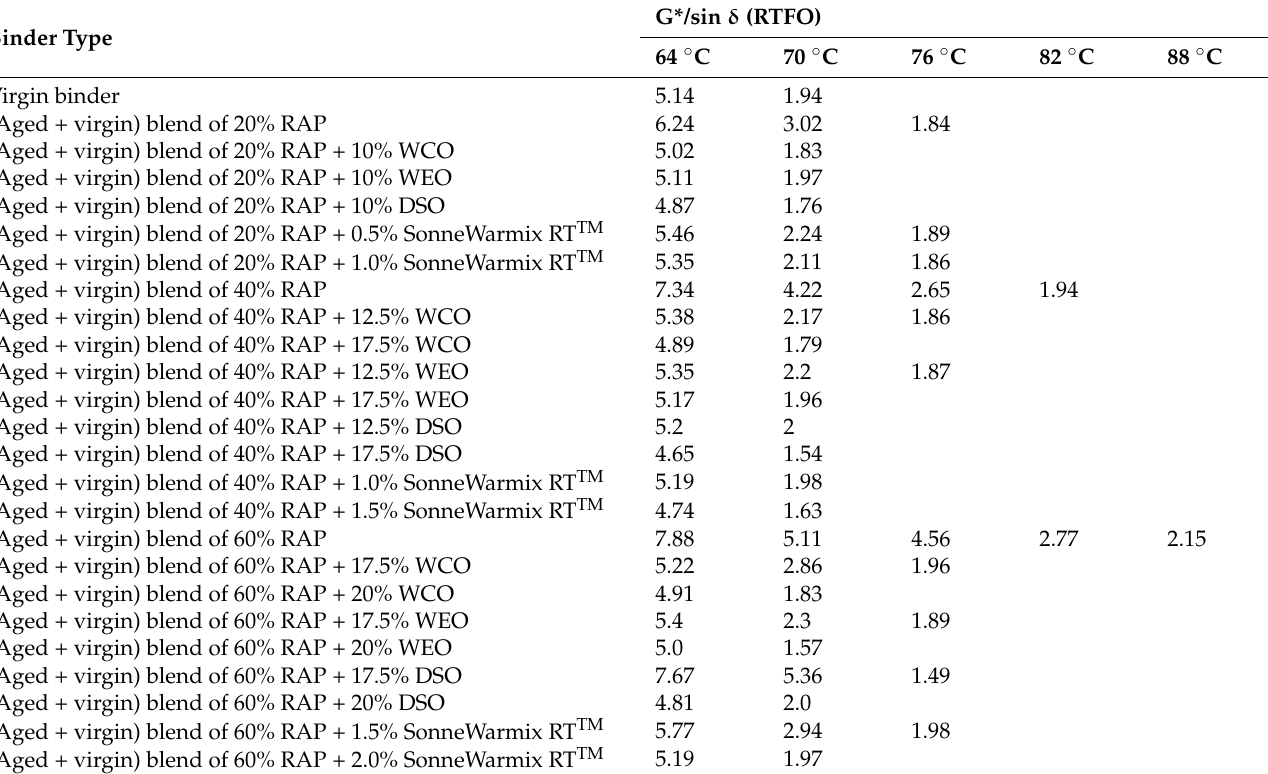
Table 20. Rutting indicator (G*/sin δ ) for the RTFO aged samples of the developed